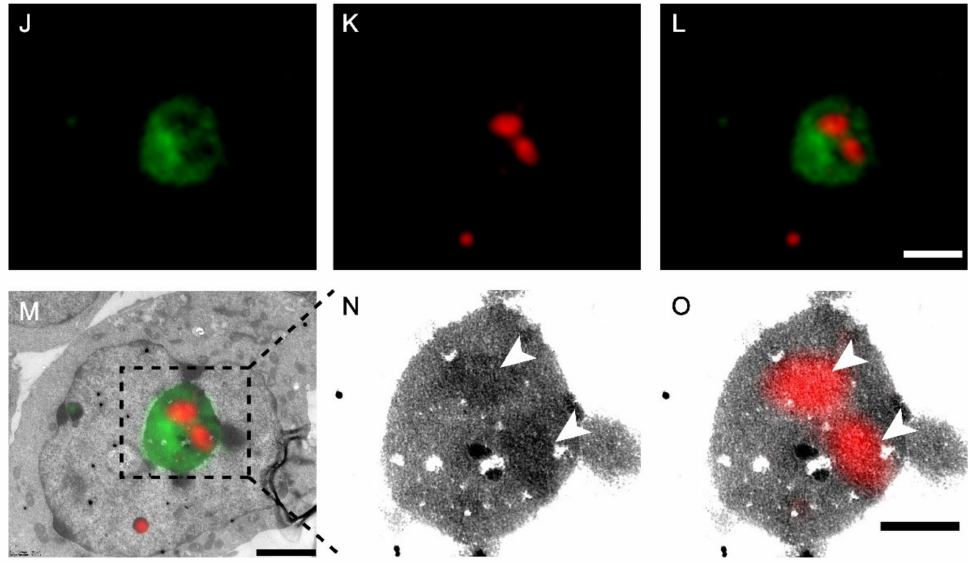
Figure 4. Dual-colour post-Epon-embedding CLEM using mEosEM-E and mScarlet-H. ( A – F ) Dual- colour imaging of mEosEM-E-labelled mitochondria and mScarlet-H-labelled LaminA protein in HEK 293T cell sections (100 nm). Representative red channel ( A ), green channel ON ( B ), and OFF ( C ) FM images. ( D ) Merged image of ( A ) and ( B ). White boxes indicate areas that showed crosstalk signals from mScarlet-H. ( E ) Green channel ON-OFF image. ( F ) Merged image of ( A ) and ( E ). White boxes indicate the same areas in ( D ). Scale bar, 5 µ m. ( G – O ) Dual-colour CLEM imaging of nucleolar proteins. OFF ( G ), ON ( H ), and ON-OFF ( I ) images of mEosEM-E labelled B23 in HEK 293T cells sections (100 nm). White arrowheads indicate areas that were not visible in ( G ) and ( H ). Scale bar, 2 µ m. Green channel FM ( J ), Red channel FM ( K ), merged channel FM ( L ), and CLEM ( M ) images of HEK 293T cell sections expressing mEosEM-E labelled B23 and mScarlet-H labelled Nopp140. Gamma value: 1.6 for both channels. Scale bars, 2 µ m. ( N – O ) Enlarged EM ( N ) and CLEM ( O ) images of boxed area in ( M ), white arrowheads indicate the localization of Nopp140 that showed higher EM contrast compared to B23. Gamma value: 1.6 for red channel. Scale bar, 1 µ